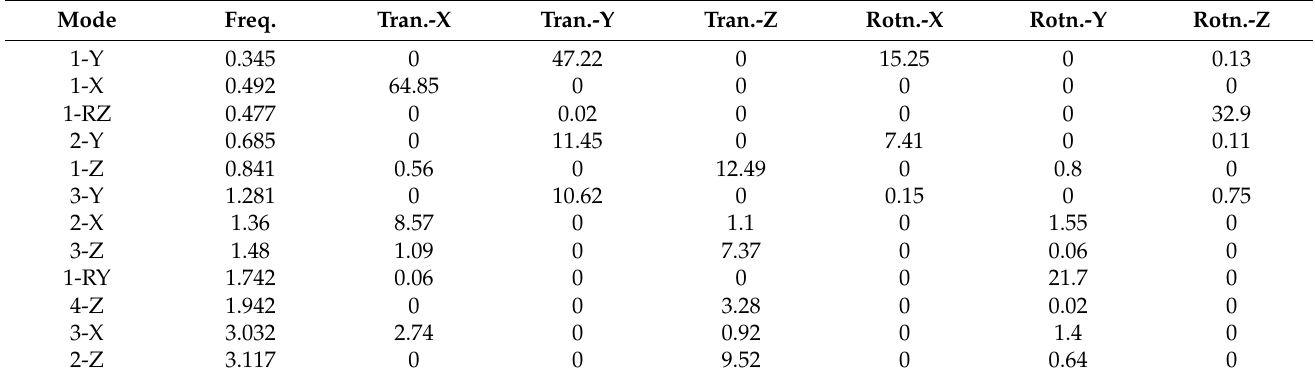
Figure 3. FE model of the Tablazo bridge MIDAS Civil©. Table 1. Frequencies and modal participation factors obtained from the FE